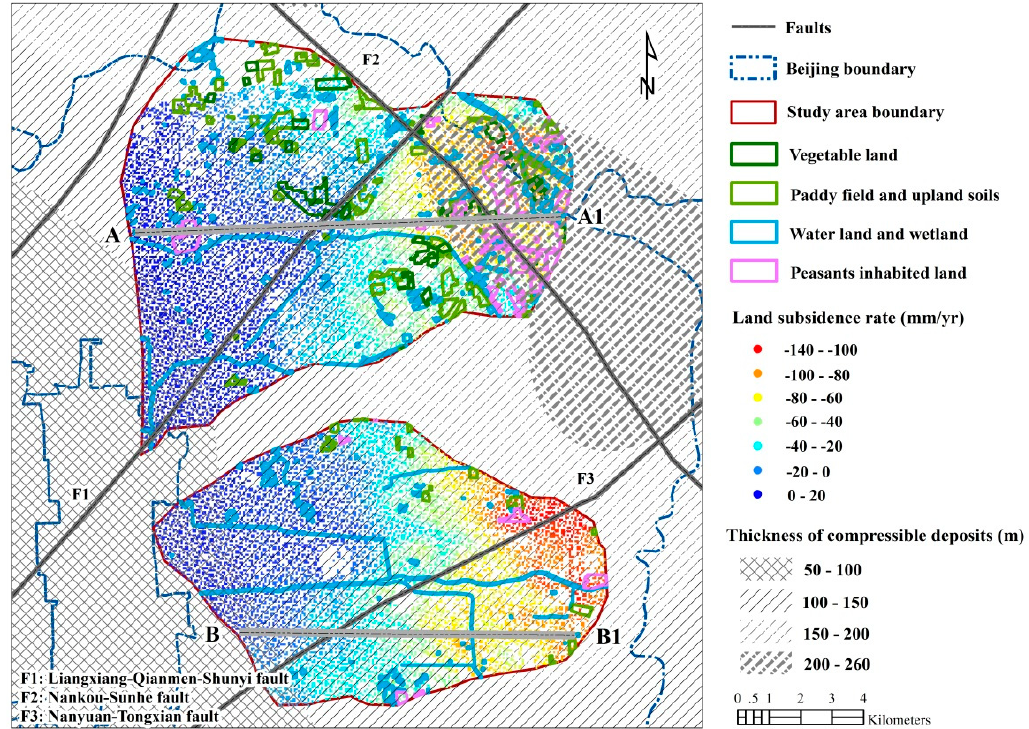
Figure 8. Land use types are indicated with different contour colors: the blue is water area and wetland, the dark green is vegetable land, the light green is paddy field and upland soils area, and the purple is peasant-inhabited land. The five gray patterns divide the compressible deposits thickness into four classes with a thickness ranging from 50 to 100 m, 100 to 150 m, 150 to 200 m, and 200 to 260 m. A–A1 and B–B1 are two profiles perpendicular to F1, F2, and F3.